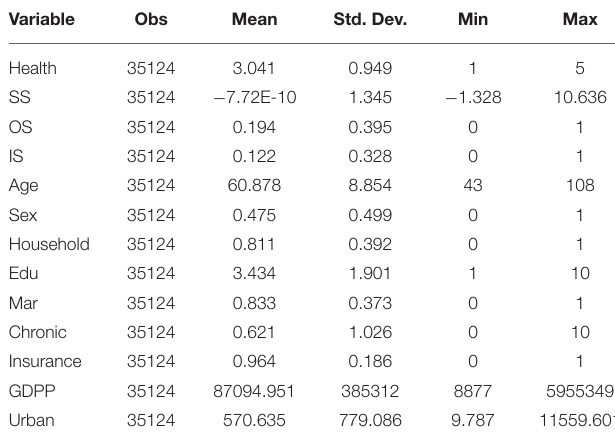
TABLE 3 | Descriptive statistics of